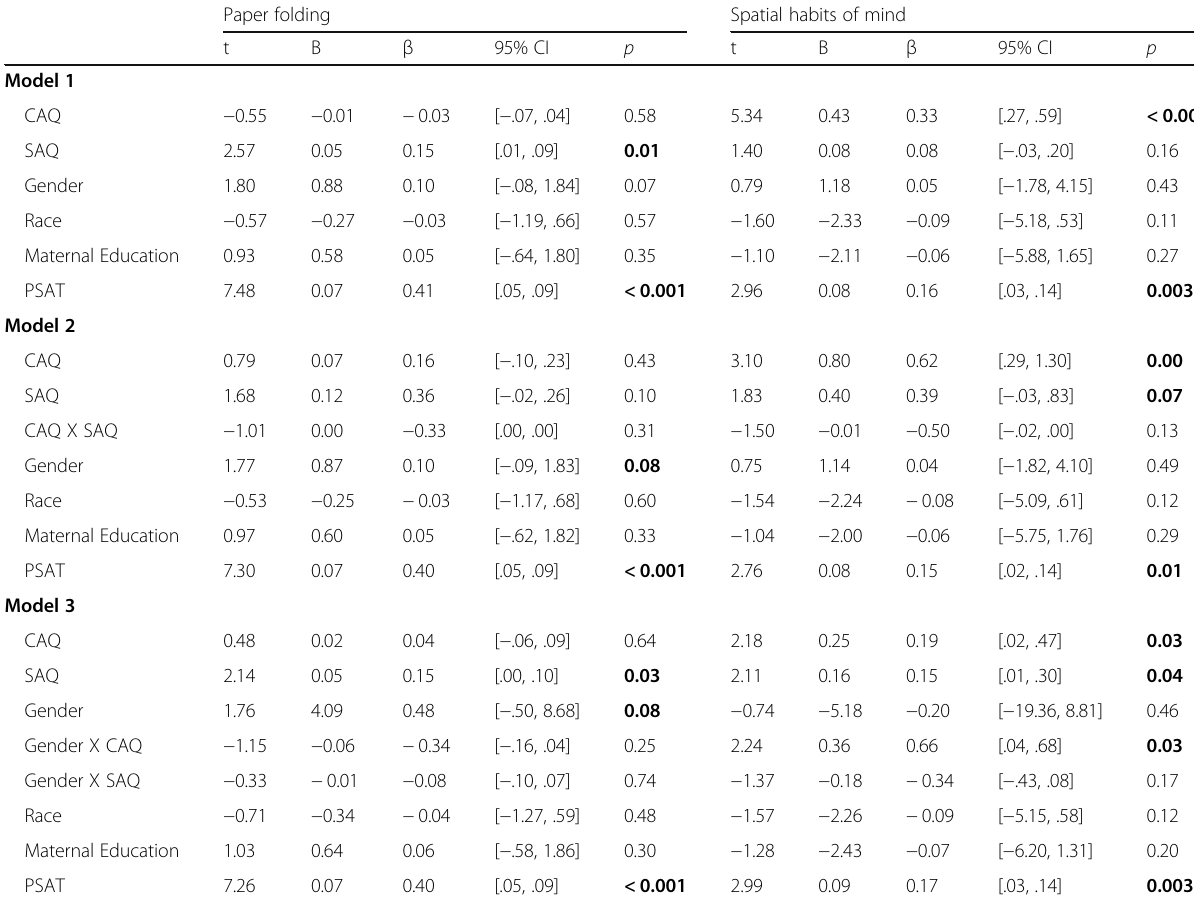
Table 3 Multivariate regression models Paper